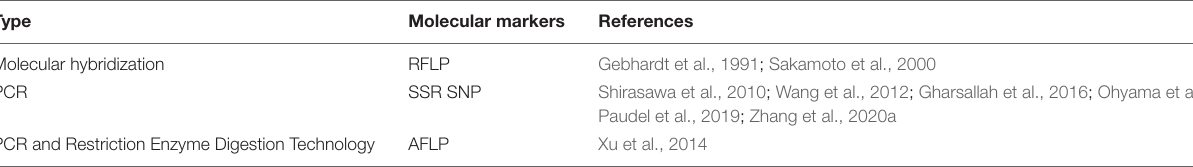
TABLE 1 | Different types of molecular markers.